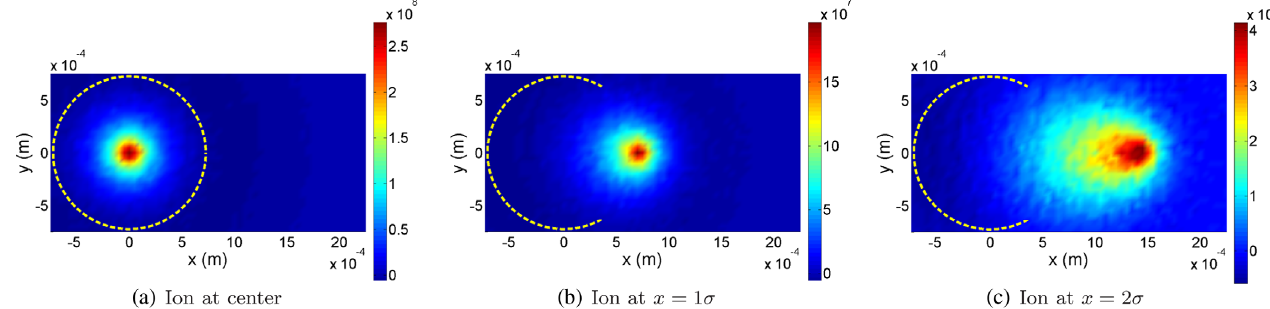
FIG. 7. 2D (x and y) plots of transverse density modulation of electrons at the exit of the modulator, measured in numbers of electrons per square meters, by resting ion at three transverse positions inside the Gaussian electron beam. The dashed yellow circle indicates the RMS size of Gaussian distribution of the electron beam, which is centered at the center of the beam.